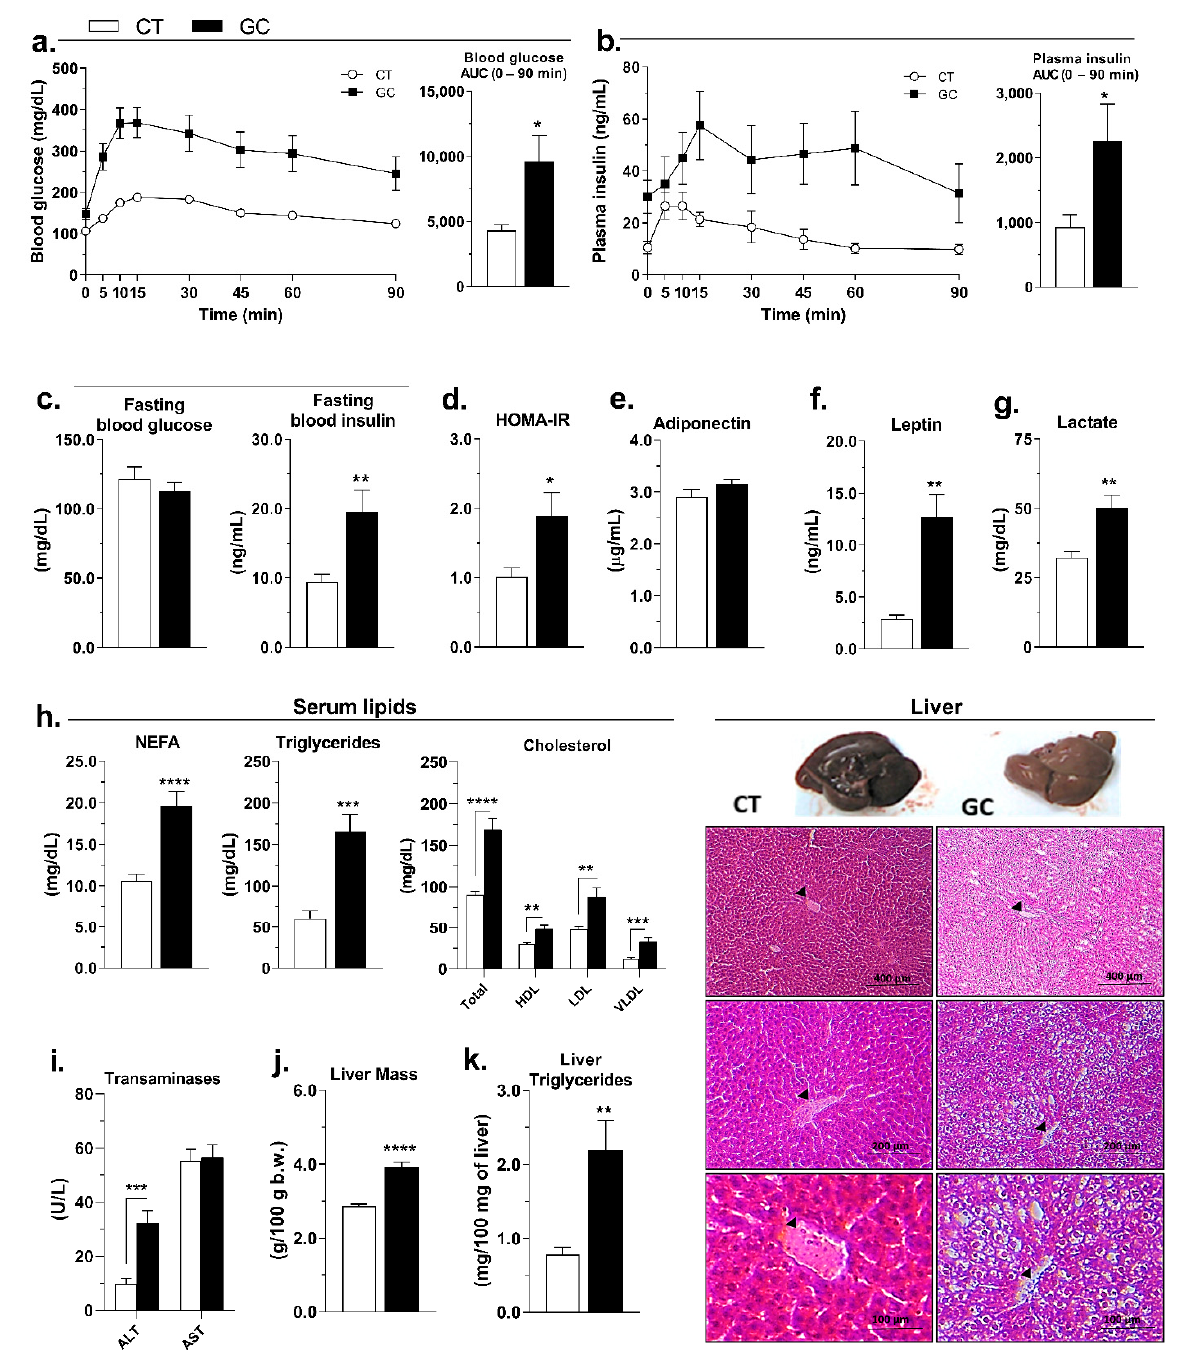
Figure 2. Chronic iatrogenic hypercortisolism promotes glucose intolerance, insulin resistance, dyslipidemia, and increase of hepatic lipid content. ( a ) Blood glucose and ( b ) plasma insulin during oGTT test; ( c ) 12h fasted blood glucose and insulin; ( d ) HOMA-IR; serum ( e ) adiponectin, ( f ) leptin; ( g ) lipids-NEFA, triglycerides, total cholesterol, HDL, LDL, and VLDL-cholesterol fractions; ( h ) lactate, and the ( i ) transaminases ALT and AST; ( j ) liver mass, ( k ) triglycerides content, and histological sections of control (CT), and glucocorticoid-treated (GC) rats. HE staining; 100 × , 200 × , and 400 × magnification; the black arrows indicates the central vein. Data are mean ± SEM of 13 (CT) and 17 (GC) rats/samples. * p < 0.05; ** p < 0.01; *** p < 0.001, and **** p < 0.0001 vs. CT (unpaired Student t - test, Mann–Whitney test in b -AUC, and c -fasting glucose).